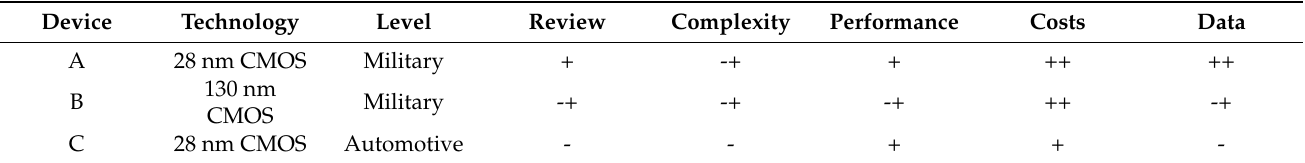
Table 7. Device assessment for the signal-processing block.